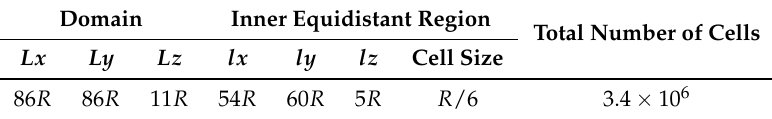
Figure 3. Top view of WindSim generated mesh. (Grid resolution at ground level, R is the wind turbine radius). Table 2. Domain